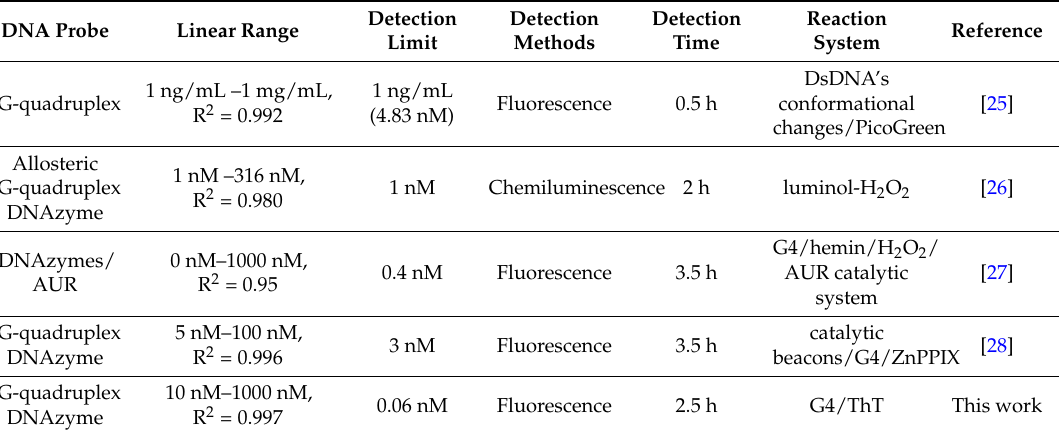
Table 1. Comparison of similar Pb 2+ sensors.